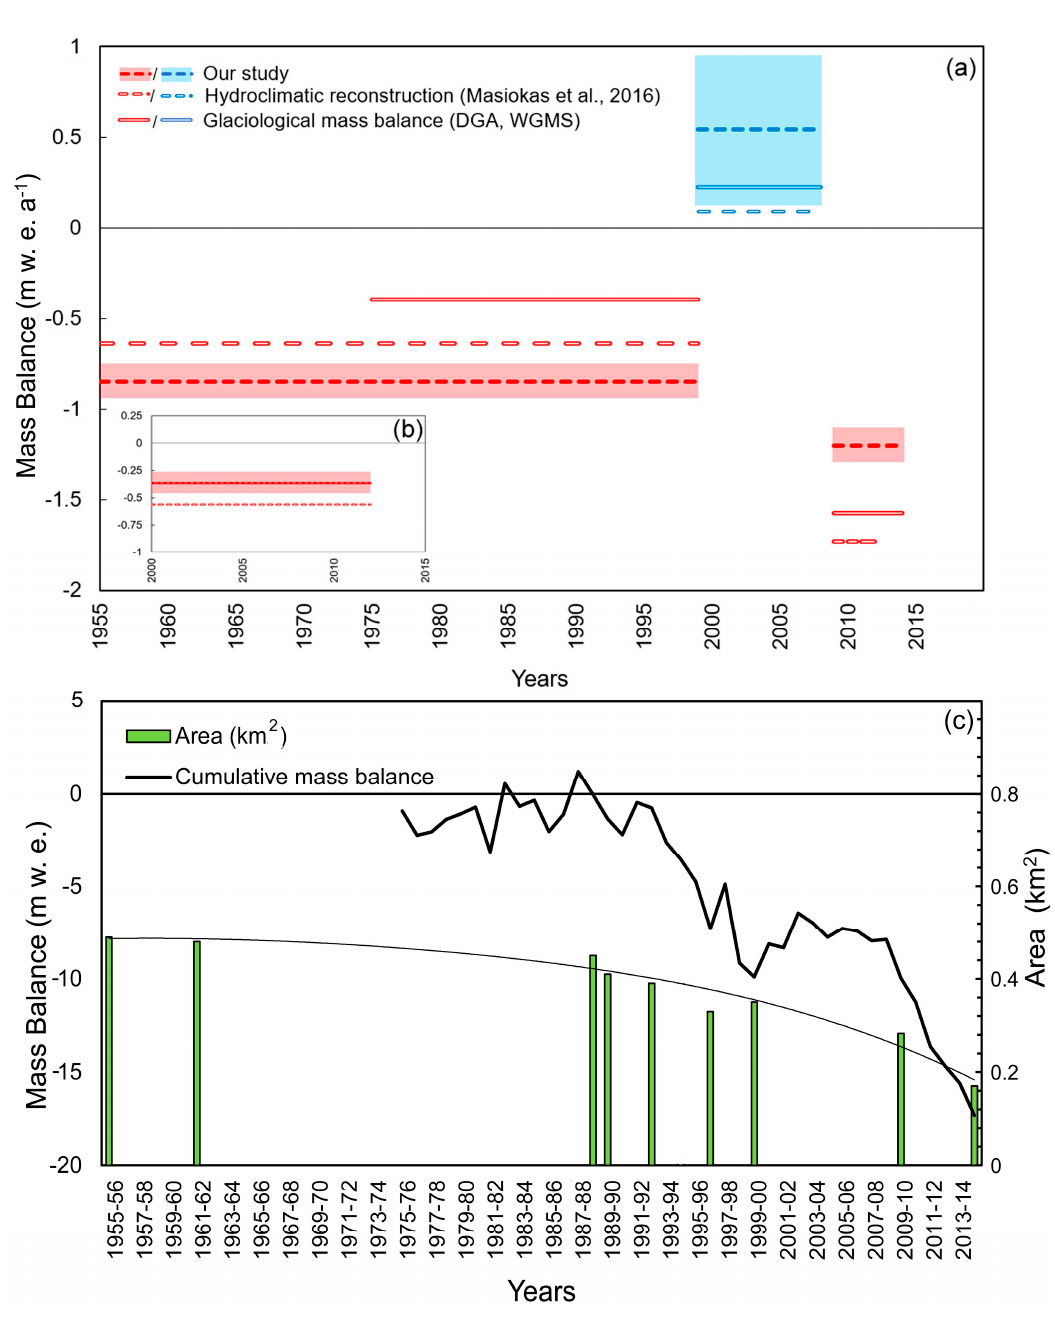
Figure 4. ( a ) Compilation of different mass balances data between 1955 and 2015. Comparison between mean annual mass balances (Glaciological method, WGMS) with the mean glacier mass balance derived from the hydroclimatic reconstruction from Masiokas et al., [33] and the geodetic mass balance with uncertainty estimations in transparent (cyan and red). ( b ) Comparison between 2000–2013. ( c ) Areal changes and the cumulative mass balance of Echaurren Norte Glacier (WGMS) from 1955 to